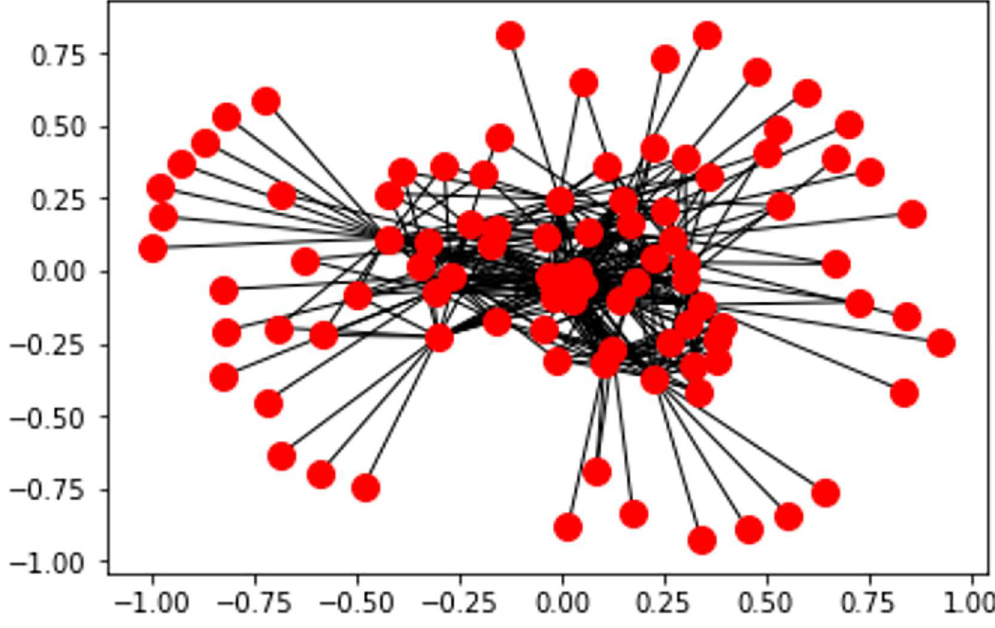
Fig 22. Station-polarity graph generation after edge